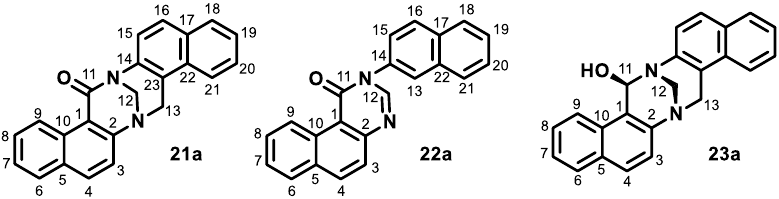
Scheme 6. Molecular structures of oxo-TB 21a , oxo-quinazoline 22a , and an unidentified exo -diastereomer of hydroxy-TB 23a (racemic).